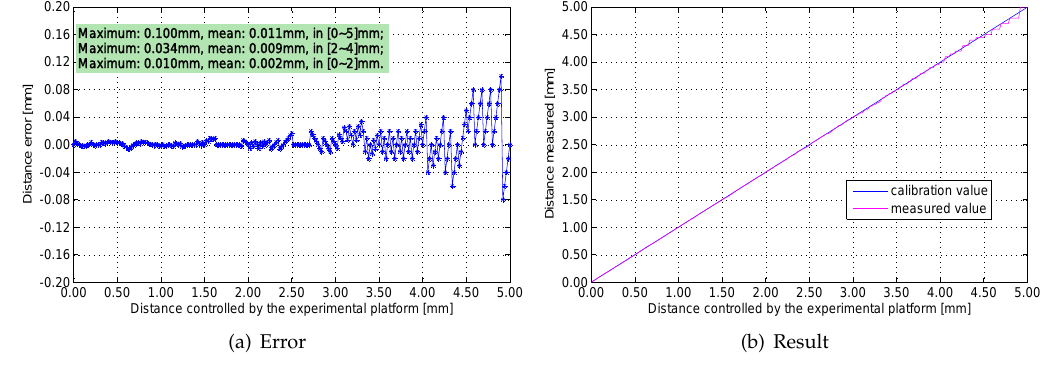
Figure 16. Measurement errors and results at 20 ◦